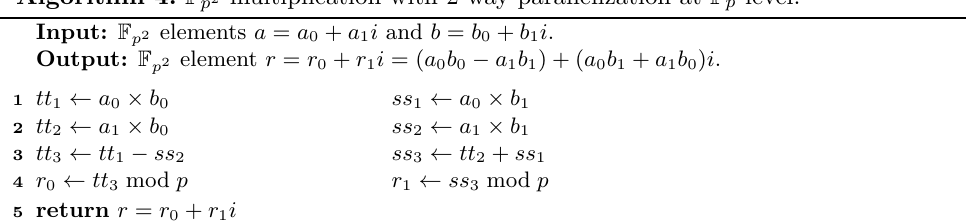
Algorithm 4: F -multiplication with 2-way parallelization at F p -level. p 2